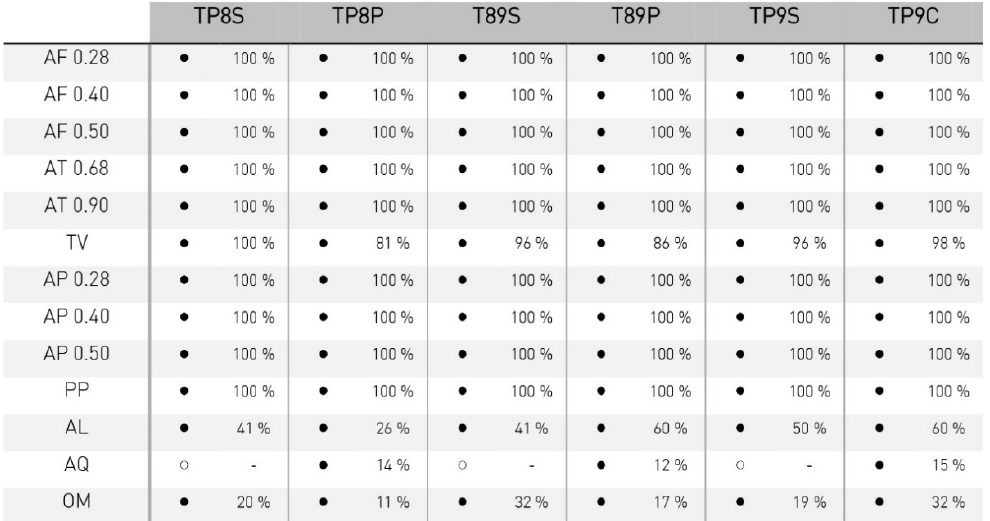
Figure 11. Climate adaptive design solutions for each of the test spaces are expressed as a percent- age.